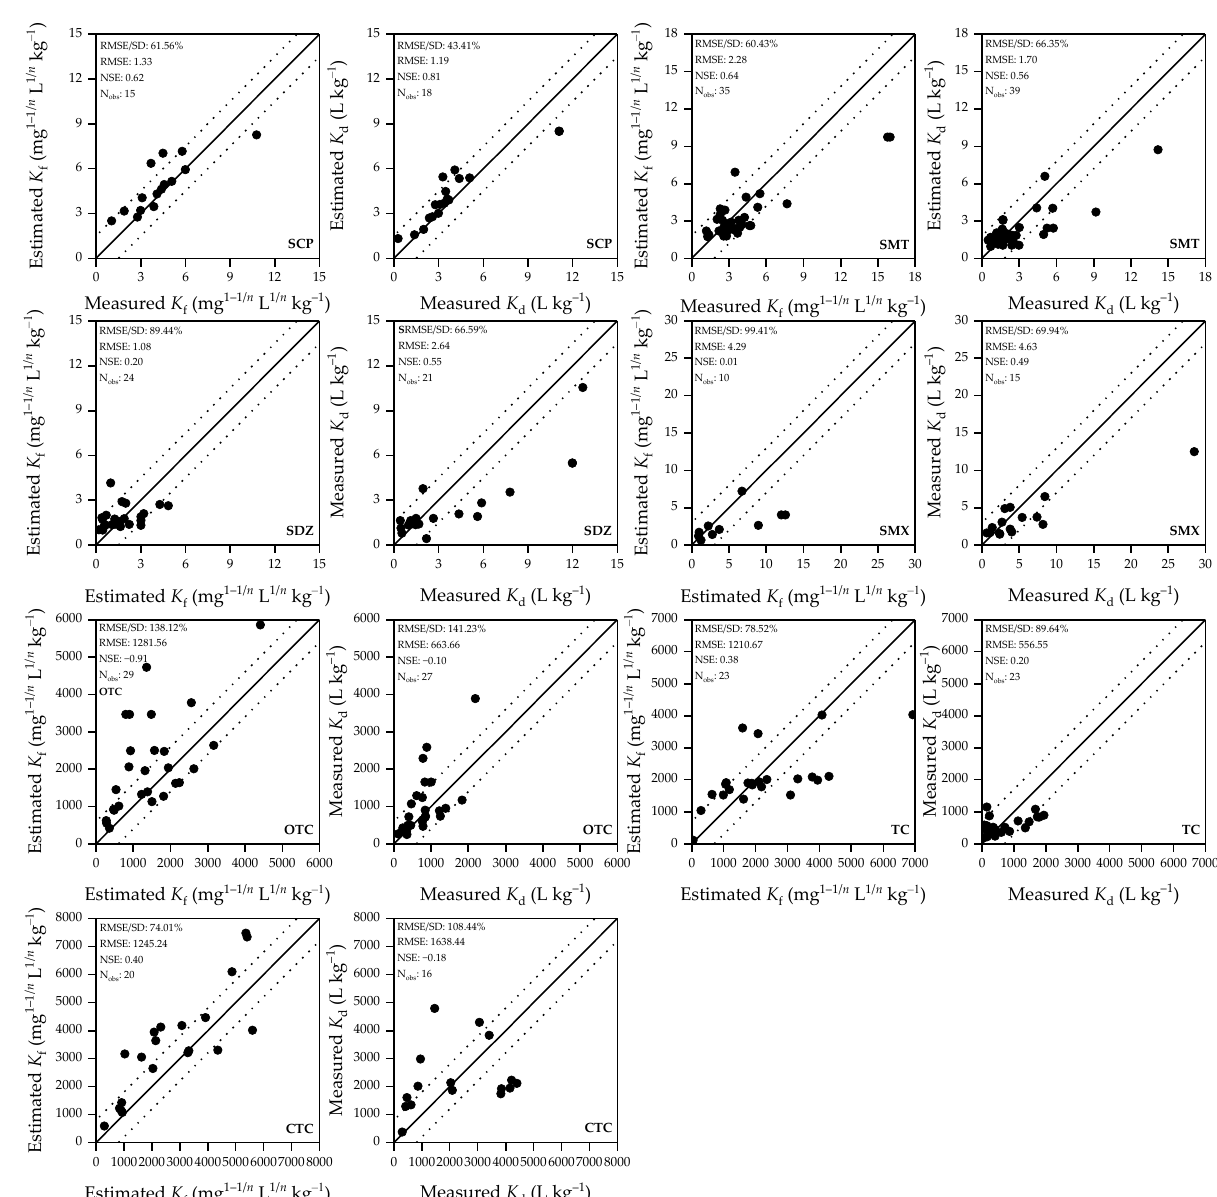
Figure 1. Measured K f and K d in sub-datasets “a” and “b” against estimated K f and K d from the pedotransfer functions. The solid line represents a perfect model fit (1:1 line), and the dashed lines represent a difference of one order of magnitude, which indicate satisfactorily estimated values.